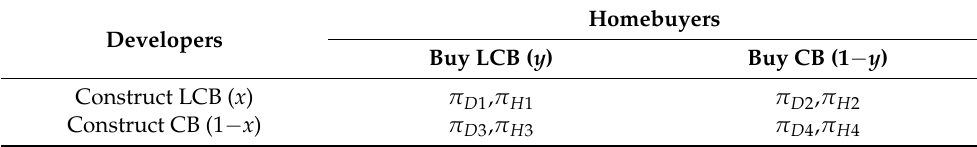
Table 2. Payoff matrix between the developers and